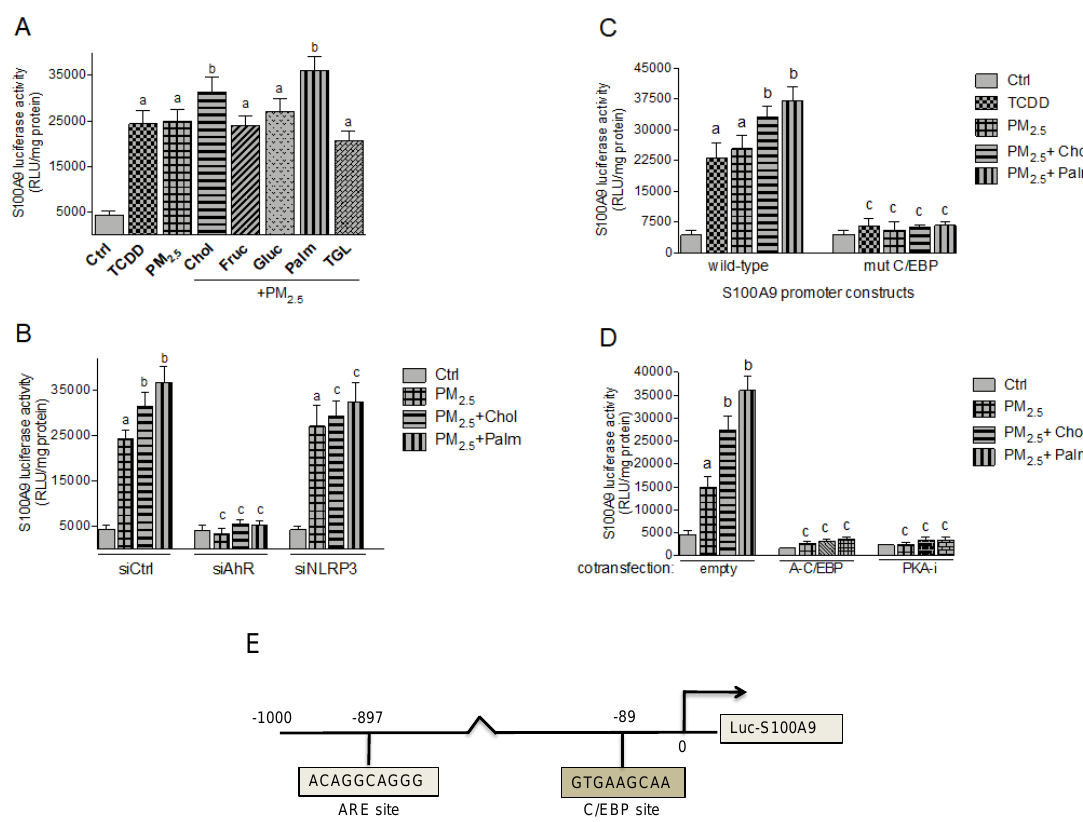
Figure 7. E ff ect of nutritional compounds on PM 2.5 -induced S100A9 promoter activity. ( A ) Umac were transiently transfected with a luciferase promoter construct containing 1000 bp upstream of the regulatory sequence of the human S100A9 gene promoter. After 24 h cells were treated with 1 nM TCDD and 10 µ g / mL PM 2.5 in the presence or absence of nutritional factors cholesterol (Chol, 10 µ g / mL), fructose (Fruc, 25 mM), glucose (Gluc, 25 mM), palmitic acid (Palm, 5 µ M), and triglyceride (TGL, 10 µ g / mL) for 6 h. Control cells were treated with the corresponding vehicle. ( B ) Umac were transiently transfected with the S100A9 wt luciferase promoter construct and co-transfected with a scrambled control siRNA, a AHR-specific or NLRP3-specific siRNA. After 24 h cells were treated with 10 µ g / mL PM 2.5 in the presence or absence of cholesterol (Chol, 10 µ g / mL) or palmitic acid (Palm, 5 µ M). ( C ) Umac were transiently transfected with the luciferase reporter constructs of the wt S100A9 promoter or a construct containing a mutation in the C / EBP binding site. After 24 h cells were treated with 1 nM TCDD or 10 µ g / mL PM 2.5 in the presence or absence of cholesterol (Chol, 10 µ g / mL) or palmitic acid (Palm, 5 µ M). ( D ) Cells were co-transfected with an empty, C / EBP-A dominant negative expression plasmid, or a PKA inhibitor (PKA-i) expression plasmid for 24 h and treated with 10 µ g / mL PM 2.5 for 6h in the presence or absence of cholesterol (Chol, 10 µ g / mL) or palmitic acid (Palm, 5 µ M). Relative luciferase activity units (RLU) are given as mean values of triplicates as a result of three independent experiments. a significantly higher than control ( p < 0.05); b significantly higher than cells treated with PM 2.5 only ( p < 0.05); c significantly lower than cells transfected with ctrl siRNA, wild-type S100A9, or an empty vector (p < 0.05). ( E ) Schematic illustration of promoter construct of the human S100A9 gene containing 1000 bp upstream of the transcriptional start site (indicated by an arrow) cloned into a luciferase (luc) reporter vector. Positions of the C / EBP recognition site and an antioxidant response element (ARE) are presented.